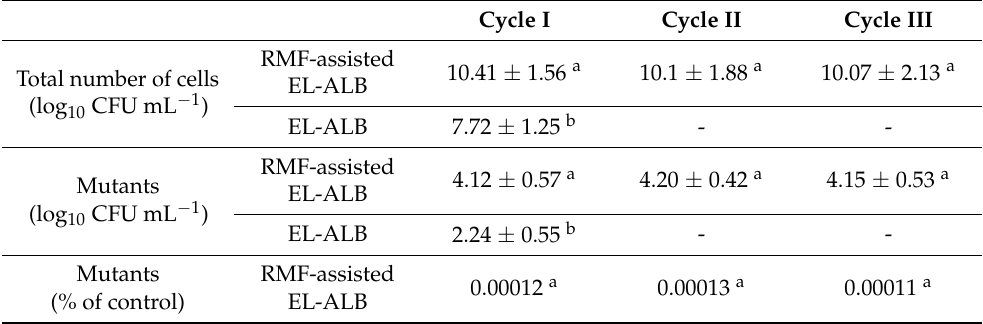
Table 2. Total number of K. xylinus cells and cellulose-deficient mutants of K. xylinus in H–S medium obtained in RMF-assisted EL-ALB and EL-ALB without RMF exposure (control).